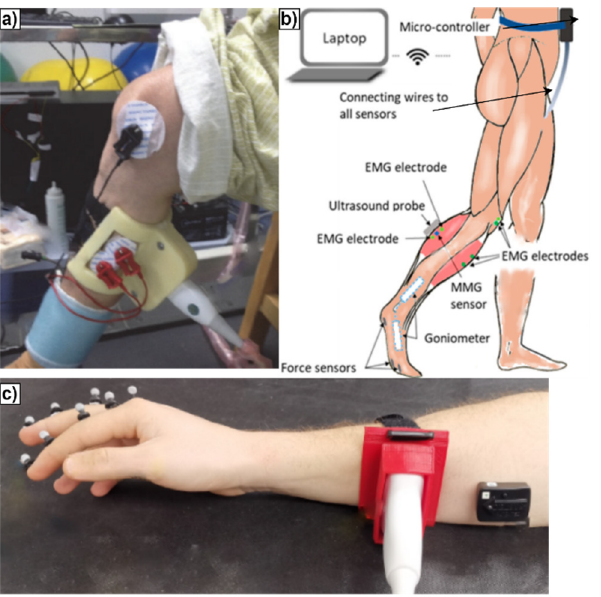
Figure 4. Adapted photographs of multi-sensor setups for physiology research: ( a ) experimental setup done by [80] with EMG, goniometer and US; ( b ) wearable mobile sensing system with real-time US imaging, EMG electrode, mechanomyography electrode, force sensors and goniometers placed in the shank and foot, developed by [10]; and ( c ) experimental setup with reflective markers placed in the back side of the hand, with US probe supported by an armband along the forearm and sEMG electrodes, presented by [81].